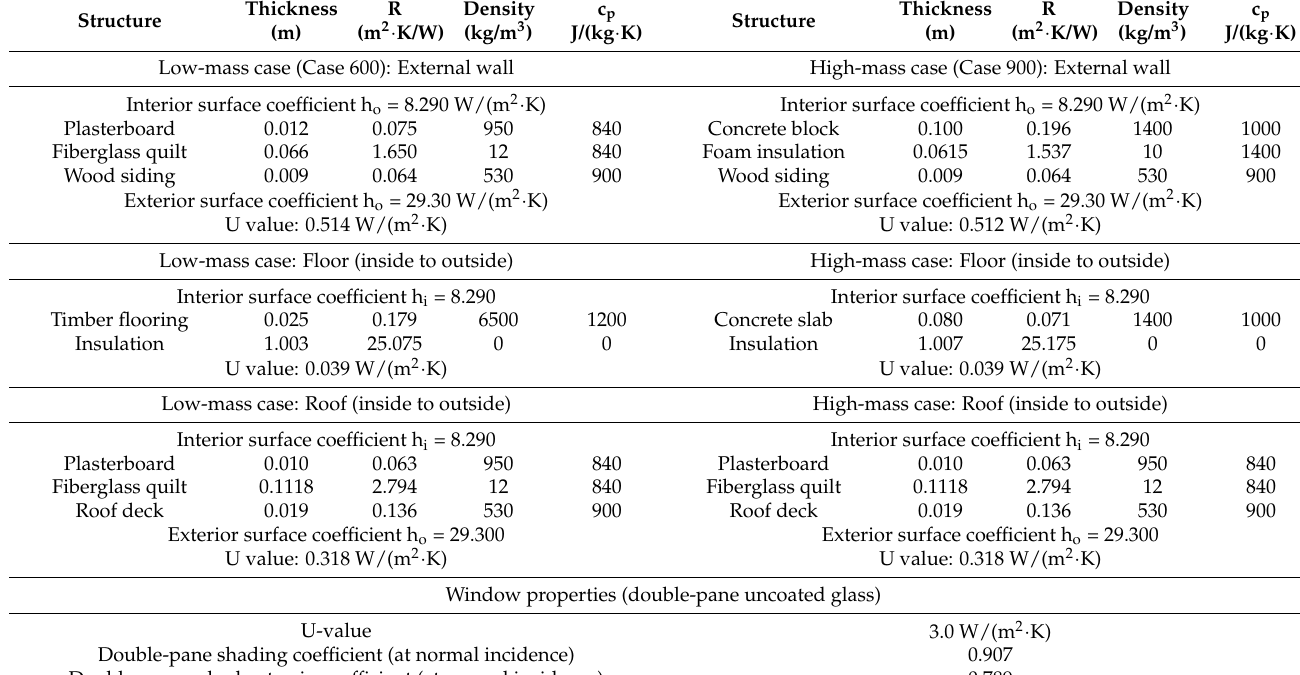
Table 4. Materials and thermophysical parameters of the low-mass and high-mass